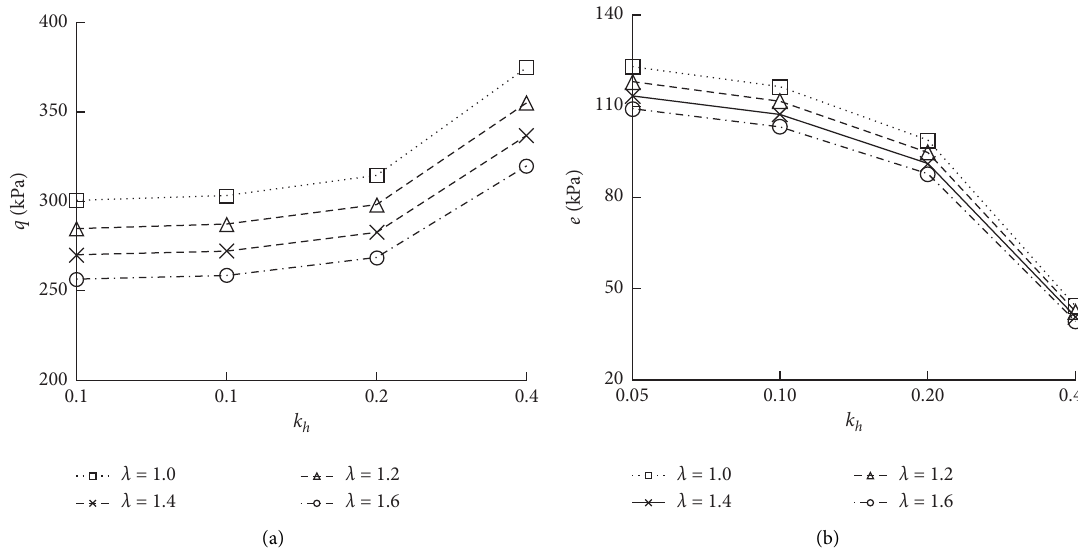
Figure 7: Influence of k h on surrounding rock pressure. (a) Vertical surrounding rock pressure. (b) Horizontal surrounding rock